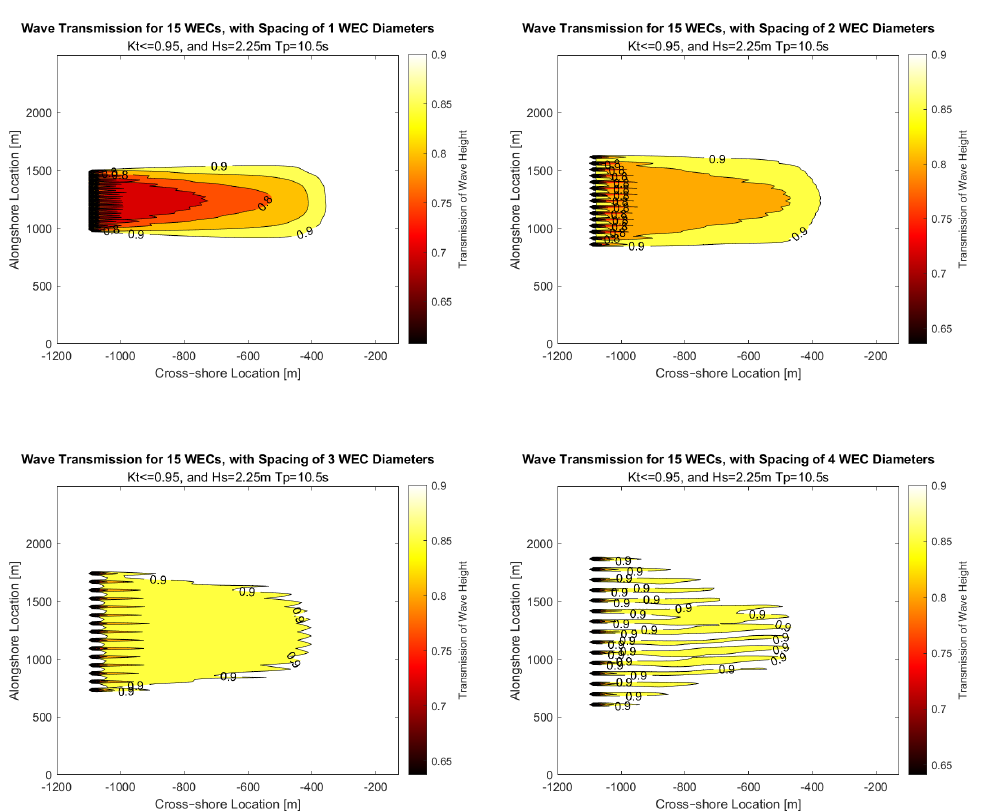
Figure 13. Normalized wave transmission magnitude and extent of wave transmission influence in the lee of the 10 WEC array. The color bar shows the percentage of transmission in the wake region.